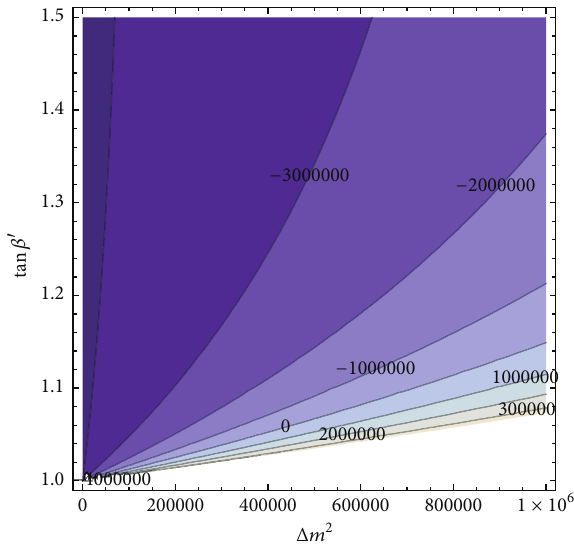
Figure 6: |𝜇 󸀠 | 2 in the (Δ𝑚 2 , tan 𝛽 󸀠 ) plane using (120) with Δ𝑚 2 = − 𝑚 2 𝑚 2 𝜂 . I have chosen 𝜂